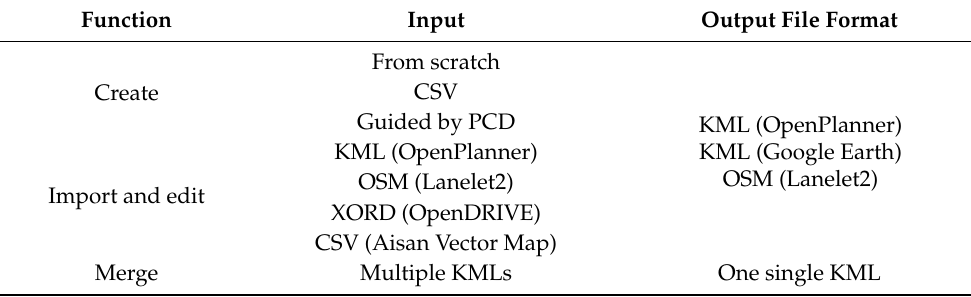
Table 13. List of function and input and output file formats provided in ASSURE.